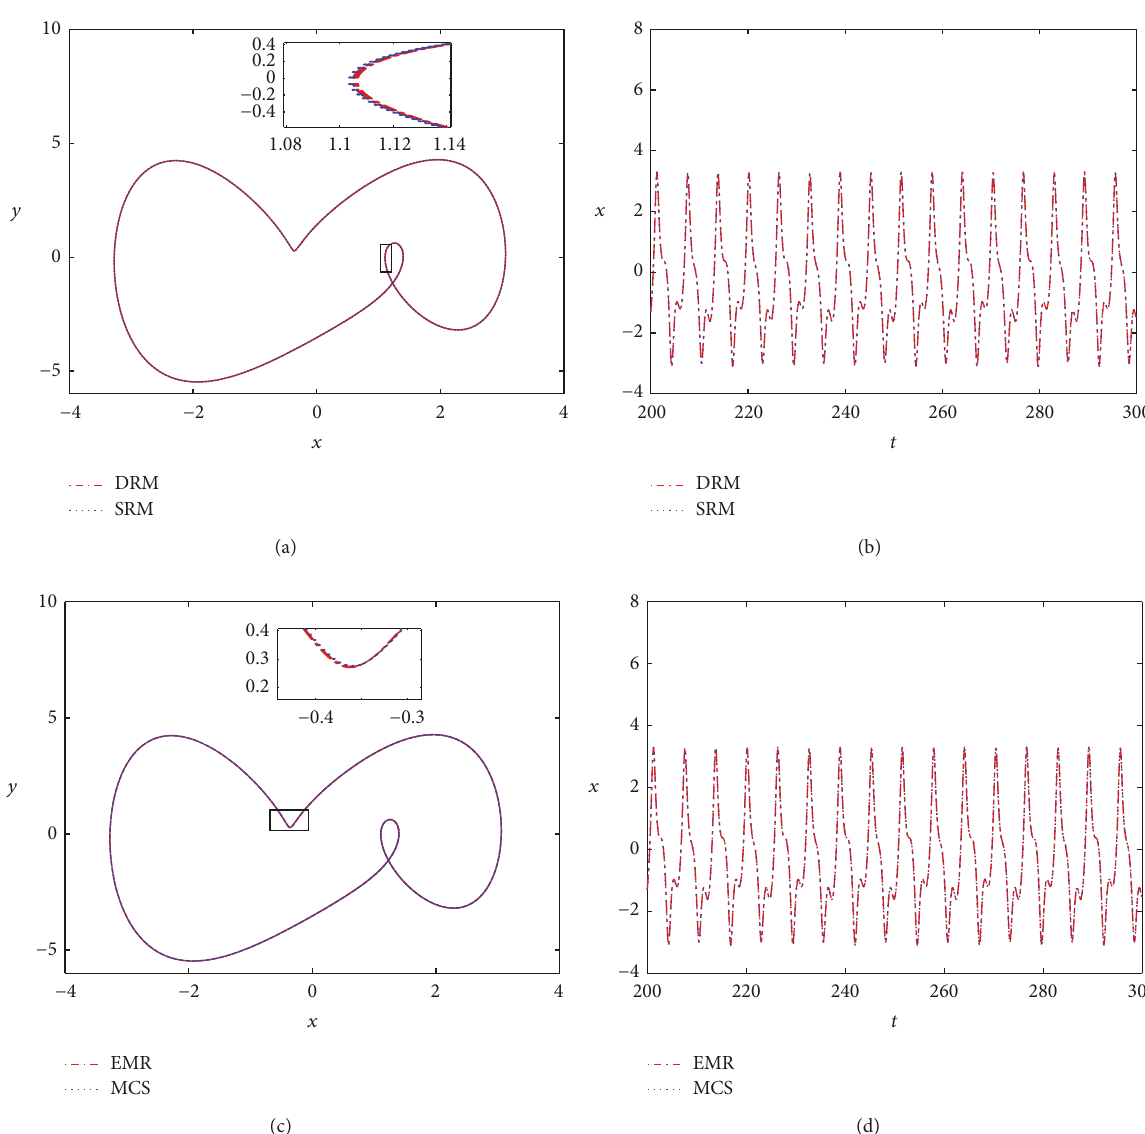
Figure 3: Period 1 𝑇 for 𝑞 = 0.984 : (a) phase portrait for DRM-SRM; (b) time history diagram for DRM-SRM; (c) phase portrait for EMR- MCS; (d) time history diagram for